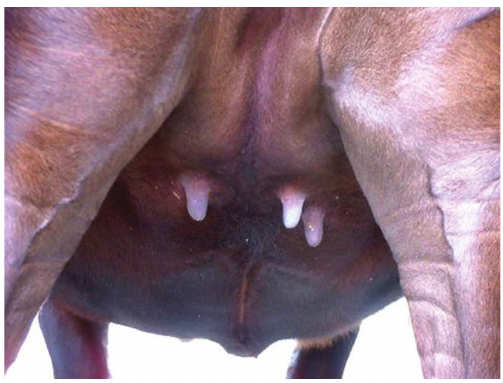
Figure 1: Japanese Black heifer with athelia showing absence of the fore left teat.